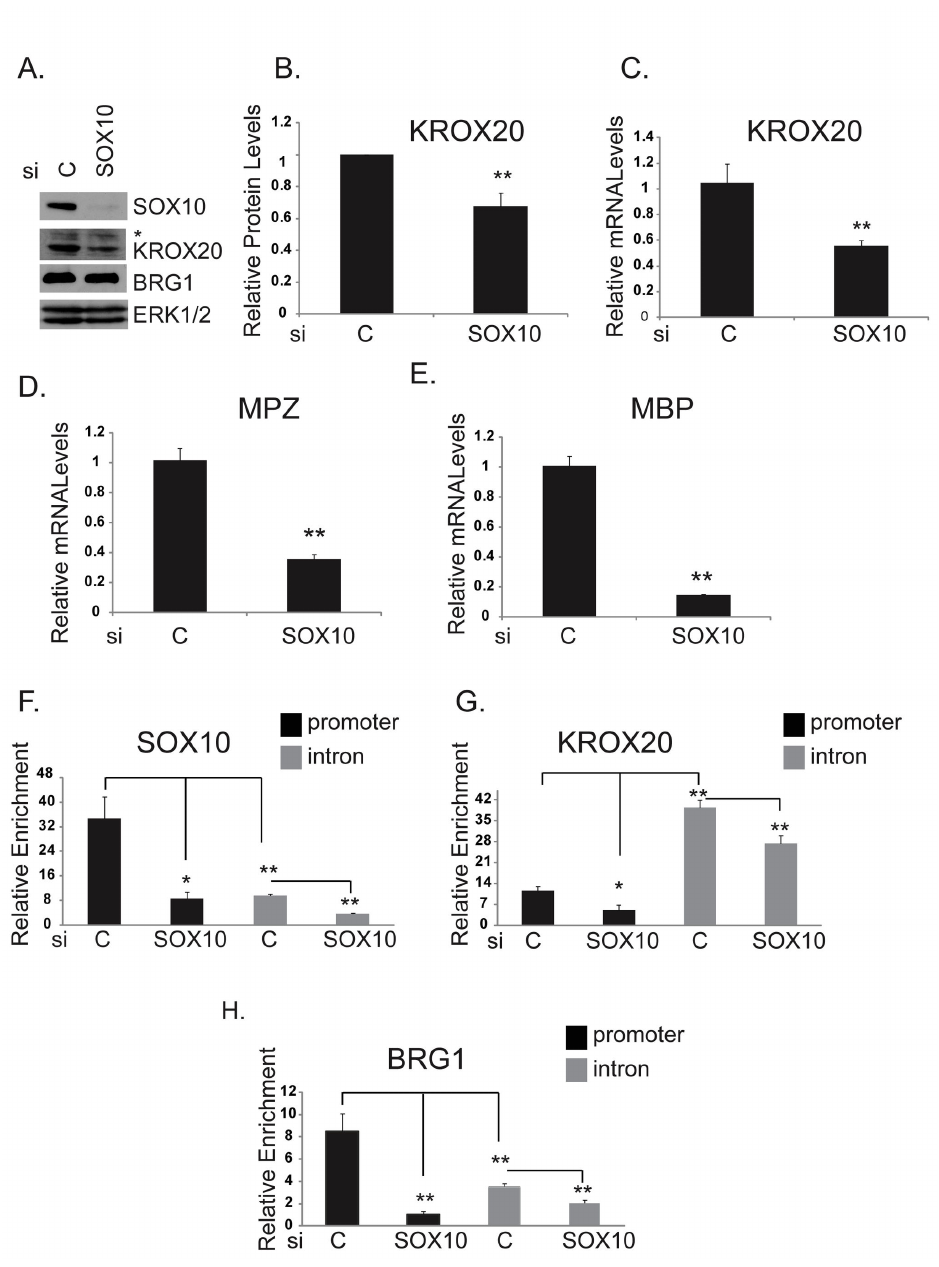
Figure 5. SOX10 is required to recruit BRG1 to the MPZ promoter in S16 Schwann cells. A. Cell extracts were prepared from S16 cells that were transfected with siControl or siSOX10 and subjected to Western analysis with antibodies to SOX10, KROX20, and antisera to BRG1 (The starred top band (*) in the KROX20 Western may be a non-specific band. It was not used in the quantitation of KROX20 expression shown in Figure 5B. ERK1/2 is shown as a loading control. B. Quantitation of KROX20 protein levels relative to ERK1/2 protein levels by ImageJ software. The data are the average of three independent experiments. Standard error bars and statistical significance are shown (**p<0.01). C–E. Quantitative RT-PCR (qRT-PCR) of KROX20, MPZ, and MBP mRNA levels. F–H. ChIPs were performed with control IgG, antibodies to SOX10 or KROX20, or antisera to BRG1 on chromatin from S16 cells that were transfected with siControl or siSOX10. Enrichment on the MPZ promoter and intron is relative to control IgG and normalized to a control region, Ig2a enhancer. There was minimal variation in the ChIP signal at the Ig2A enhancer. (F) Detection of SOX10 interactions with the MPZ promoter. (G) Detection of KROX20 interactions with the MPZ promoter. (H) Detection of BRG1 interactions with the MPZ promoter. The data are representative of three independent experiments that were assayed three times. Standard errors bars and statistical significance are shown (**p<0.01, *p<0.05). doi: 10.1371/journal.pone.0069037.g005 PLOS ONE |